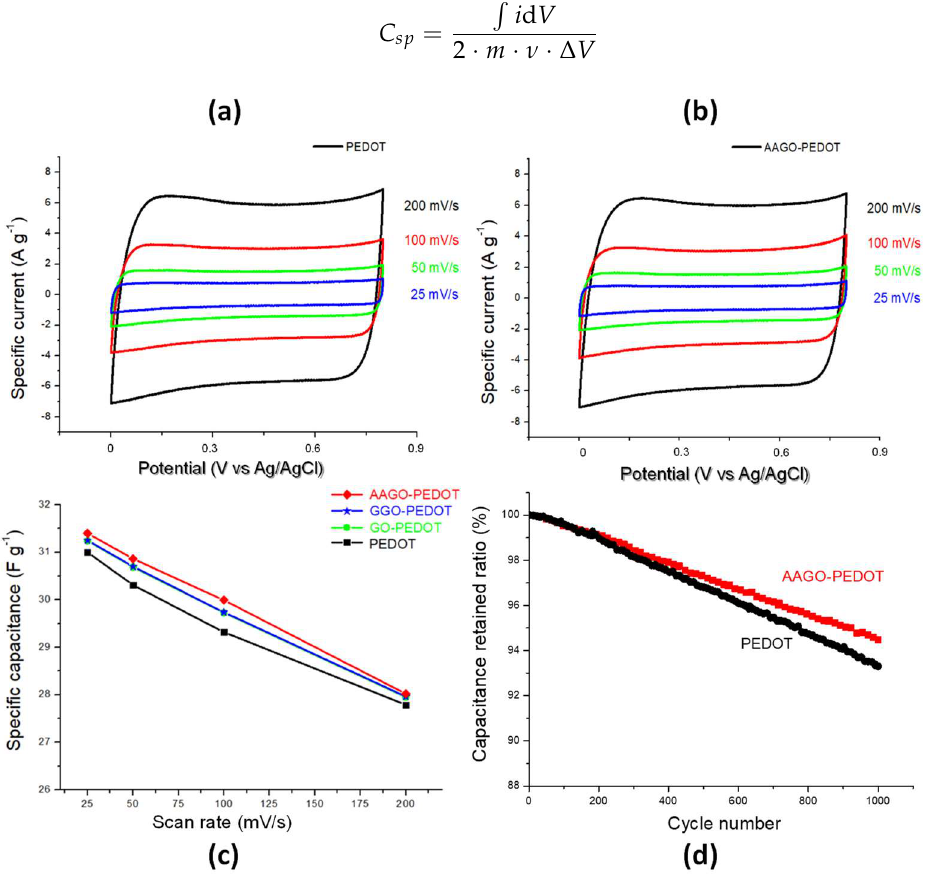
Figure 6. ( a ) AAGO-PEDOT cyclic voltammograms at different scan rates (25, 50, 100 and 200 mV/s). ( b ) PEDOT cyclic voltammograms at different scan rates (25, 50, 100 and 200 mV/s) ( c ) Comparison between PEDOT:PSS, GO-PEDOT, GGO-PEDOT and AAGO-PEDOT specific capacitance ( d ) Specific capacitance as a function of the cycle number for PEDOT and AAGO-PEDOT films.